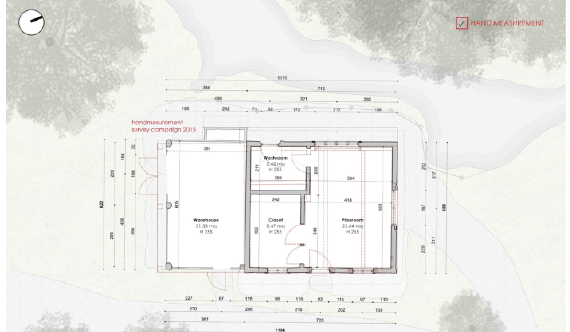
Figure 12. Refuge des Draveurs plan - comparison between hand measurement and laser scanning Figure 13. Three Level of